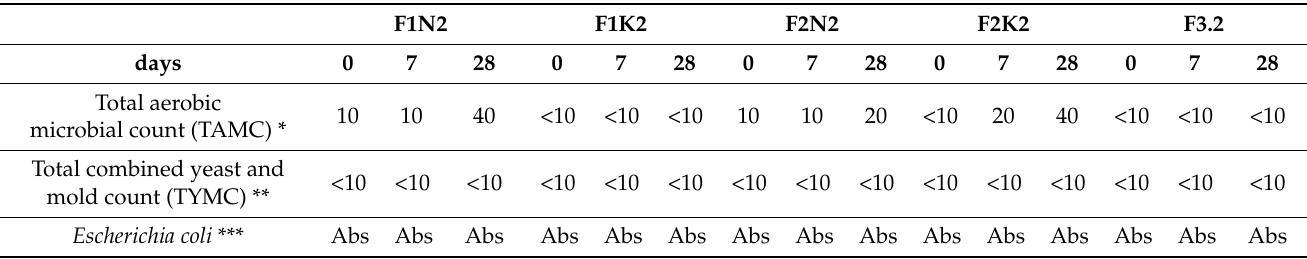
Table 3. Microbiological test of selected syrup formulations (formulations with and without preser- vative, respectively) stored in refrigerated environment for 0, 7 and 28 days, respectively. Results are presented as colony-forming units (CFU)/g.